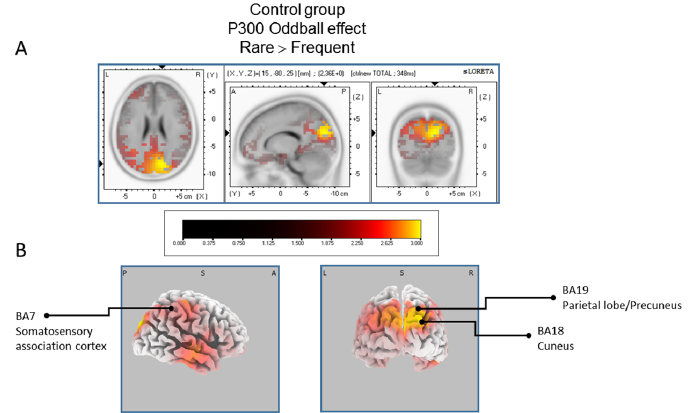
Figure 4. Results of the controls participant based on the standardized low-resolution brain electrotomography (sLORETA) current source density localization of the oddball effect (contrast: “Rare” > Frequent”) in the peak activation of the P300 component within a 300–550 ms time window. Images have been obtained after statistical non-parametric mapping (SnPM) and co-registration to the stereotaxic Talairach space based on the Co-Planar Stereotaxic Atlas of the Human Brain [83] and the probabilistic MNI-152 template [81]. Activated voxels are indicated by yellowish and reddish colors (after correction for multiple comparisons ( p < 0.01 and p < 0.05, respectively)). ( A ) The peak of highest cortical activity has been found in parts of the cuneus (BA7/18) and the precuneus (BA19). ( B ) A shifted view of the right hemisphere and the posterior cortex, showing cortical activations on the three-dimensionally rendered Colin27 template [89]. L, left; R, right; A, anterior; P, posterior; MNI, Montreal Neurological Institute; X, Y, Z, corresponding MNI coordinates; BA, Brodmann